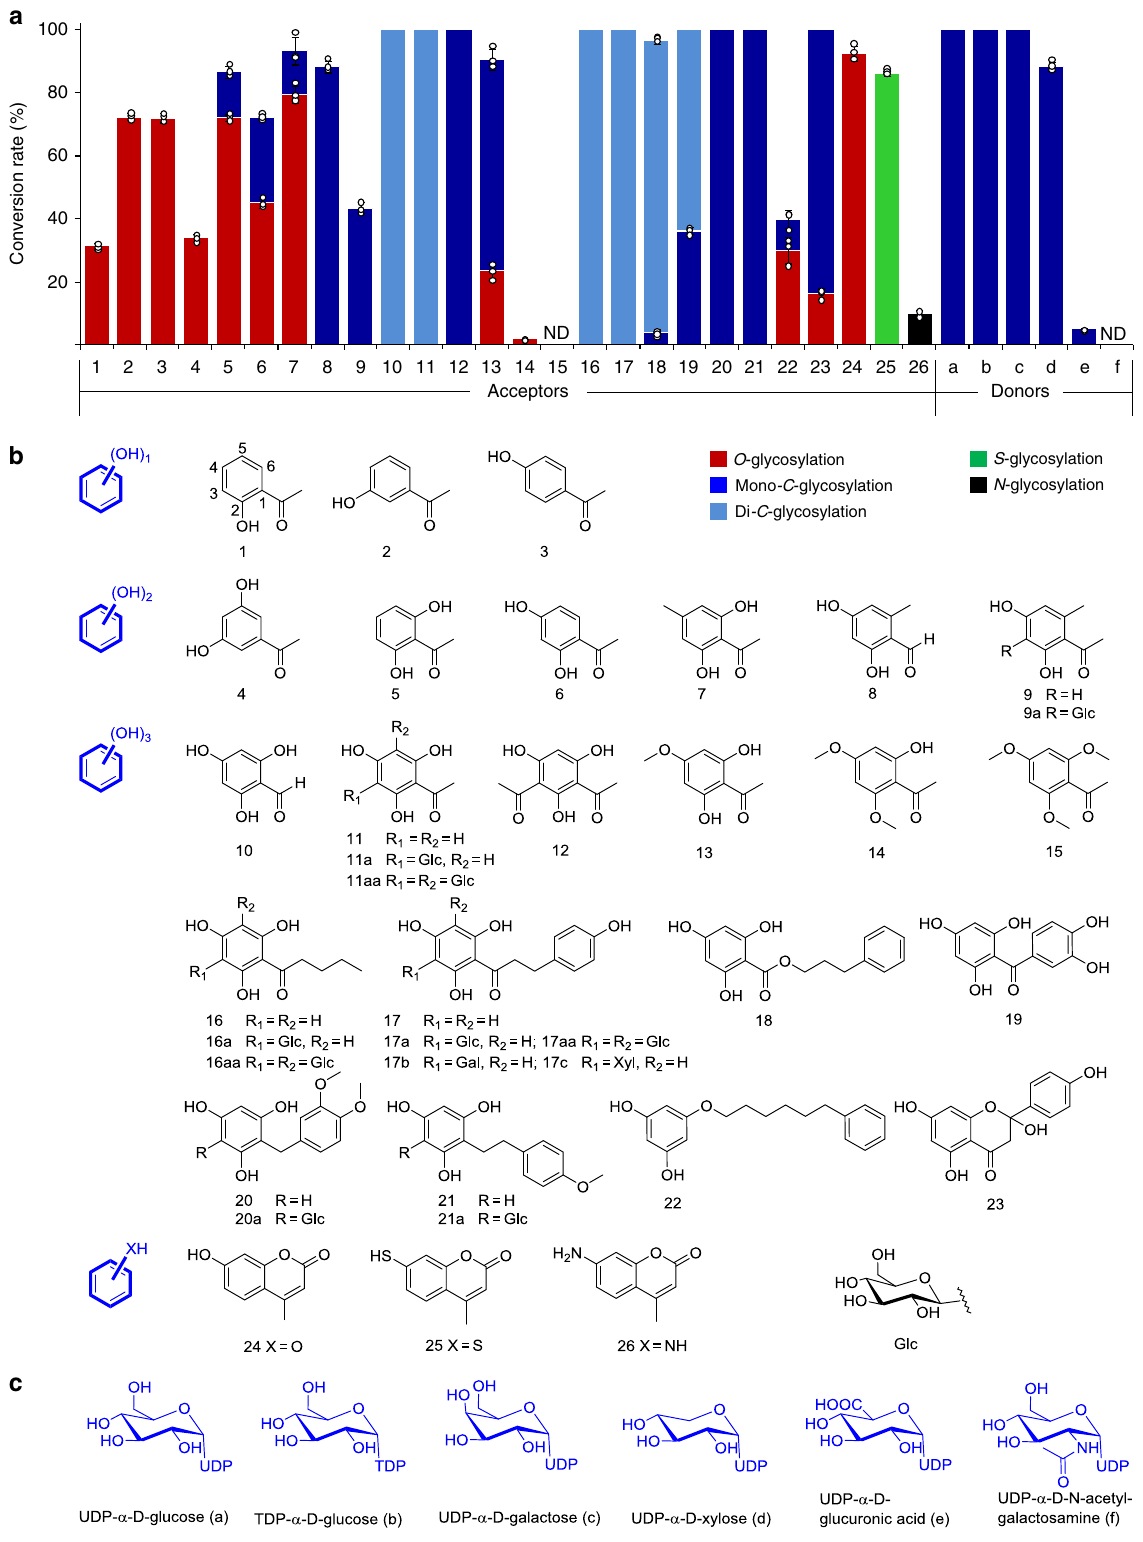
Fig. 1 Probing the aglycon acceptor and sugar donor promiscuity of AbCGT. a Percent conversion of each aglycon acceptor with AbCGT. The aglycon acceptors and sugar donors are listed based on the structural scaffolds shown in part b and c . The red, blue, light blue, green, and black columns represent conversion rates of O -, mono- C -, di- C -, S -, and N -glycosylation reactions, respectively. b The structures of the aglycon acceptors and corresponding glycosylated products prepared from the scale-up enzymatic reactions. c The structures of sugar donors used in this work. The sugar donor promiscuity was tested with phloretin ( 17 ) as the acceptor. ND not detected. Experiments were performed at pH 7.4 and 30 °C for up to 12 h. Conversion rates represent mean ± SD of three independent replicates ( n =